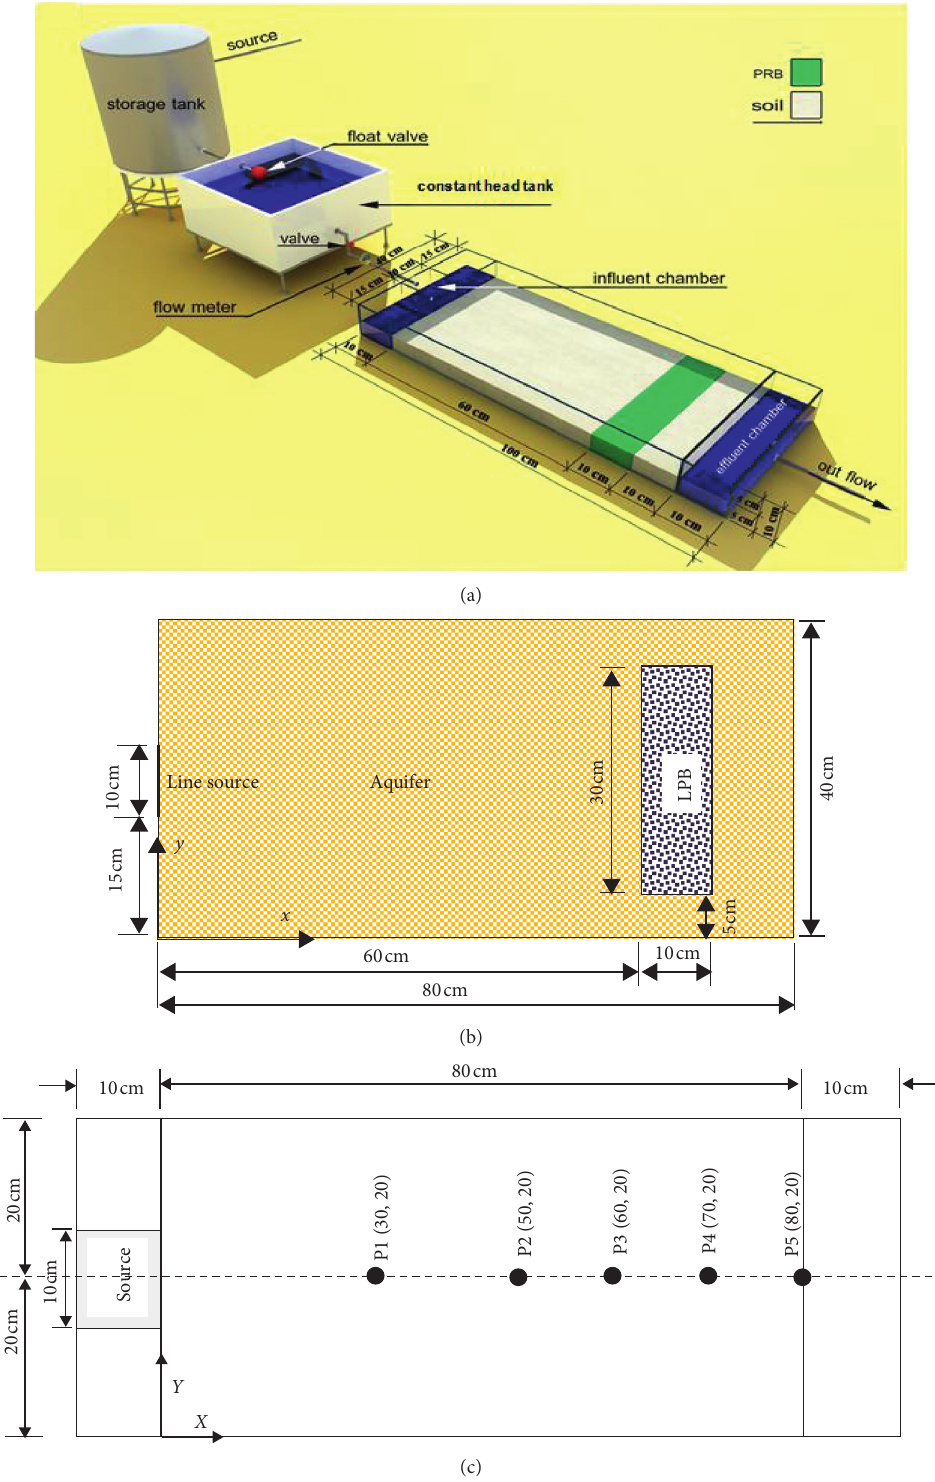
Figure 1: Schematic diagram for all components of the two-dimensional bench-scale experimental